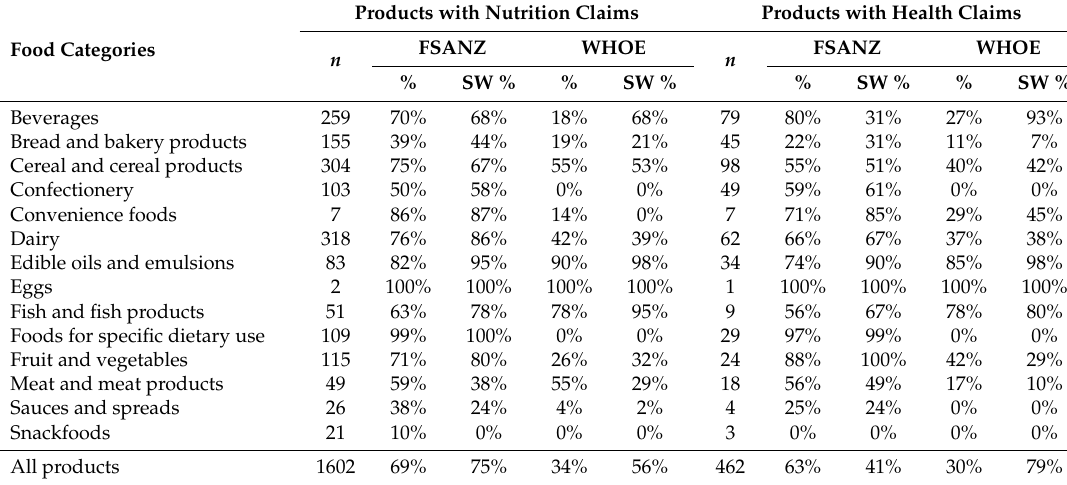
Table 5. Proportion of foods eligible by two nutrition profile models—Australia/New Zealand (FSANZ) and European World Health Organization Regional office for Europe model (WHOE); per category (products with nutrition claims and products with health claims) and the difference with sales weighted